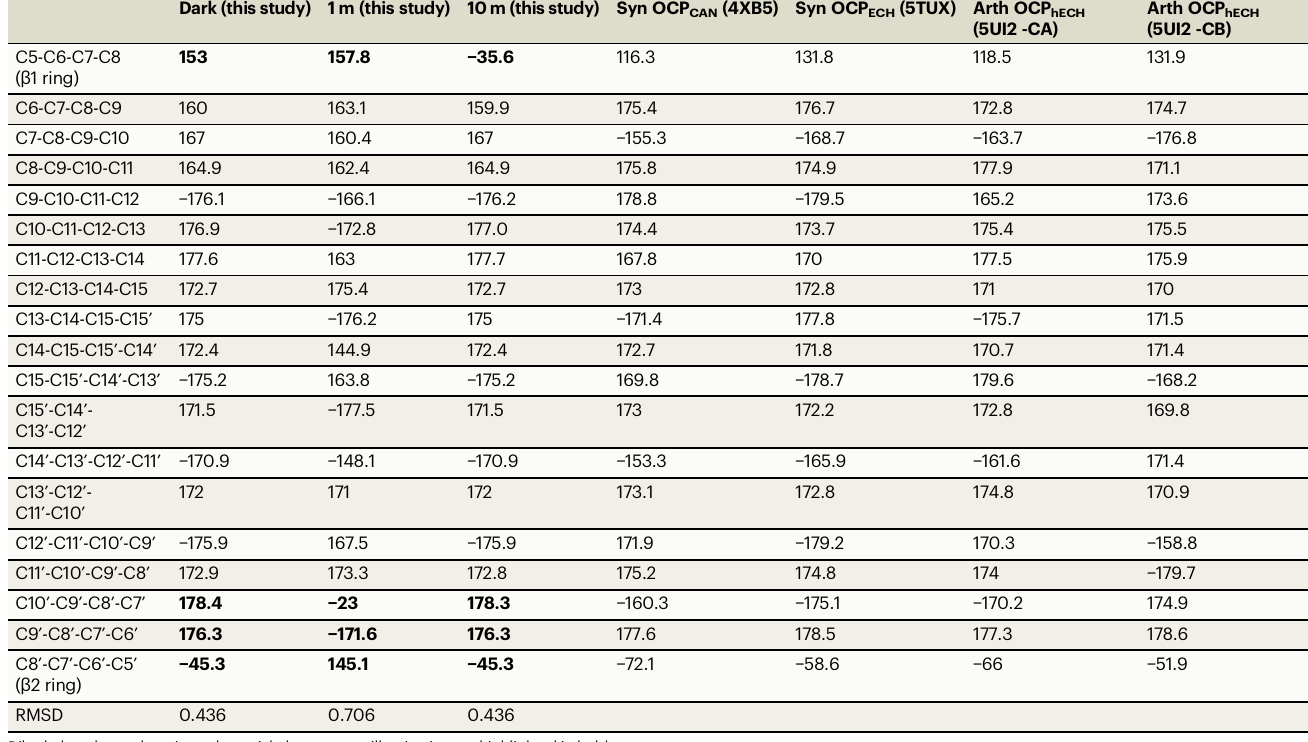
Table 1 | Comparison of canthaxanthin dihedral angles observed in OCP structures in the three states: Dark, I1 and I4. Dihedral angles were measured using atomic PDB coordinates for carbon atoms Dark(thisstudy) 1m (this study) 10m(thisstudy) Syn OCP CAN (4XB5) Syn OCP ECH (5TUX) Arth OCP hECH